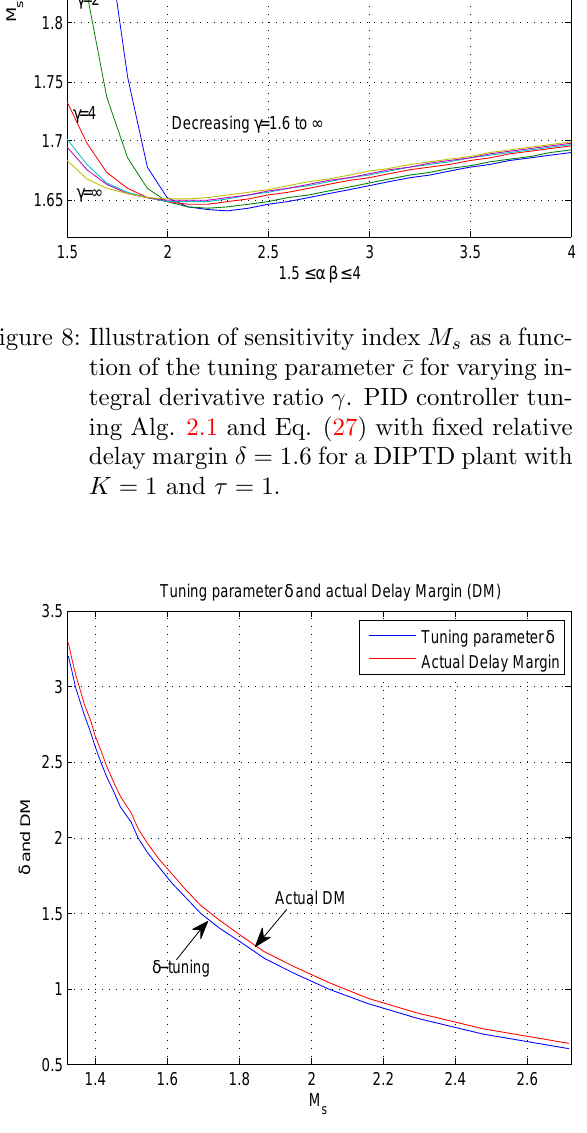
Figure 9: Illustration of the tuning parameter δ and the actual relative Delay Margin (DM) as a function of robustness M s . PID controller tuning Alg. 2.1 and Eq. (27) with varying relative delay margin δ for a DIPTD plant with K = 1 and τ =